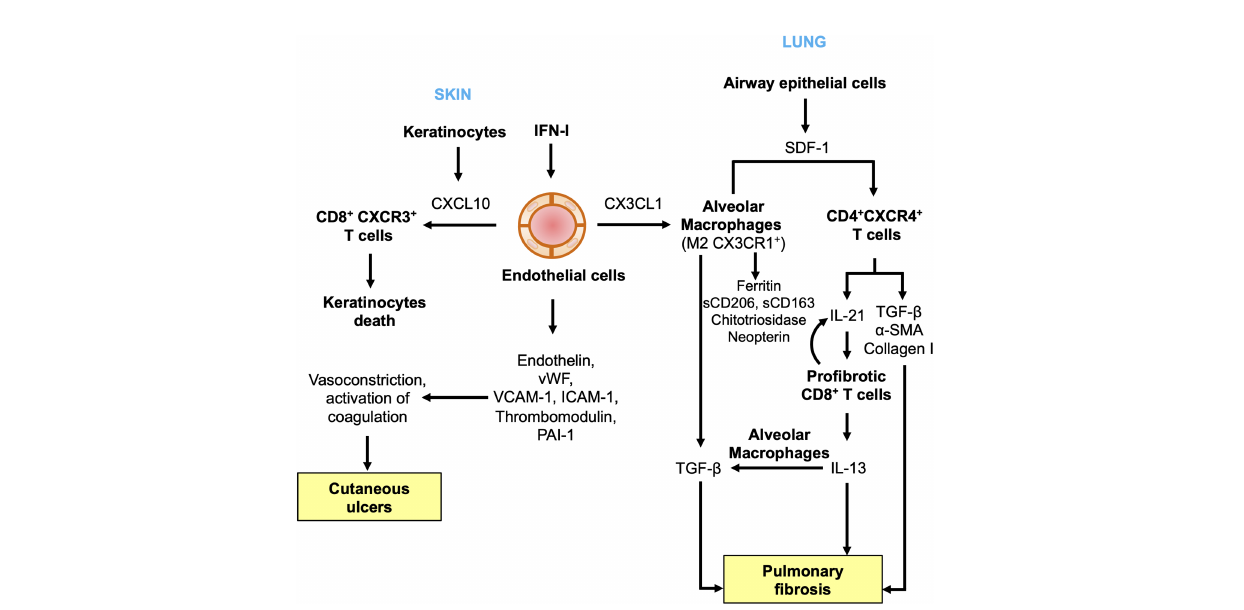
FIGURE 4 | Endothelial dysfunctions and immune alterations in anti-MDA5 dermatomyositis. In the skin, CXCL10, a keratinocyte and endothelial-derived chemokine, induces the recruitment of CD8 + CXCR3 + T cells, potentially autoreactive and leading to keratinocytes death. Endothelin released by injured endothelial cells, is a strong vasoconstrictor which can induce local ischemia responsible for cutaneous ulcers. In the lung, CX3CL1 can be produced by vascular pulmonary endothelial cells following IFN-I exposure. CX3CL1 recruits CX3CR1 + alternative alveolar macrophages (M2). Alveolar M2 macrophages, as well as airway epithelial cells, release stromal cell-derived factor 1 (SDF-1) which induces the accumulation of intrapulmonary CD4 + CXCR4 + T cells. CD4 + CXCR4 + T cells produce pro fi brotic agents (transformation growth factor- b (TGF- b ), a -smooth muscle actin ( a -SMA) and collagen I), as well as IL-21, which promotes the differentiation of pro fi brotic CD8 + T cells. CD8 + T cells secrete IL-13, which stimulates macrophages to produce pro fi brotic